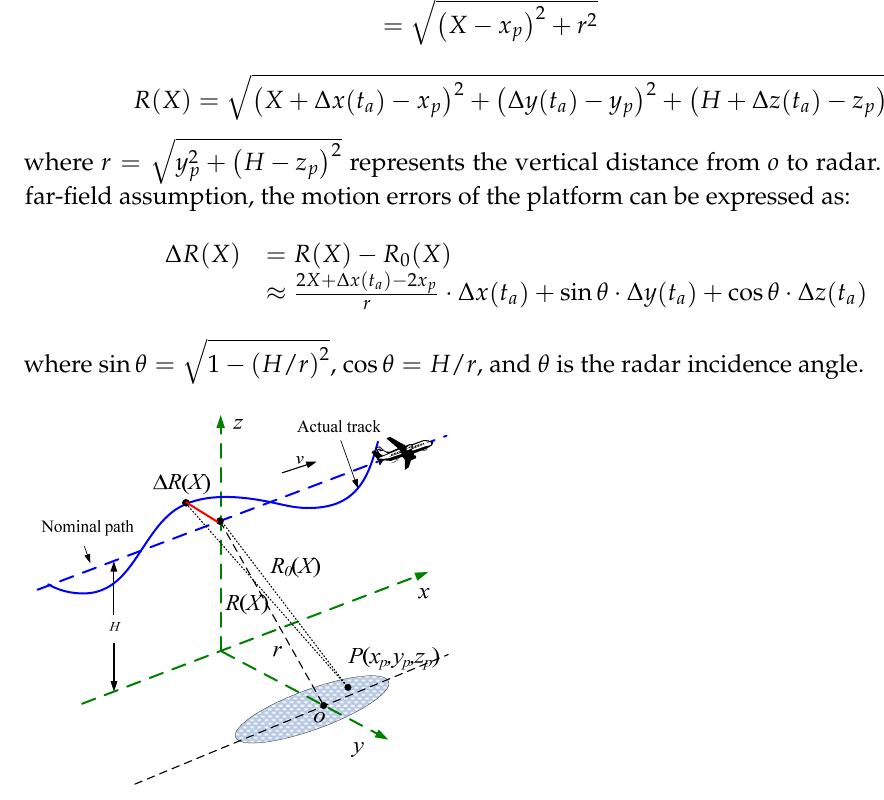
Figure 1. SAR imaging geometry with motion error.